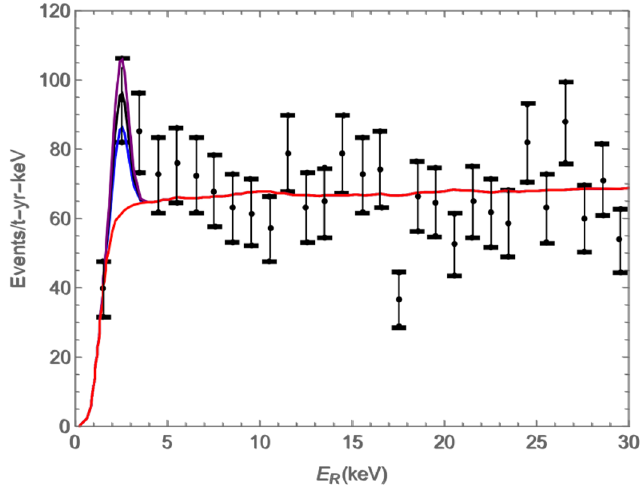
Figure 1 . The event rate for electron recoil as a function of recoil energy E R in keV. We have taken ∆ m = 2 . 5 keV and ¯ σ e /m χ = 1 . 0 , 1 . 4 , 1 . 8 × 10 − 43 cm 2 from bottom to top lines (purple, black 1 and blue. The red line is the background model used by Xenon experiment